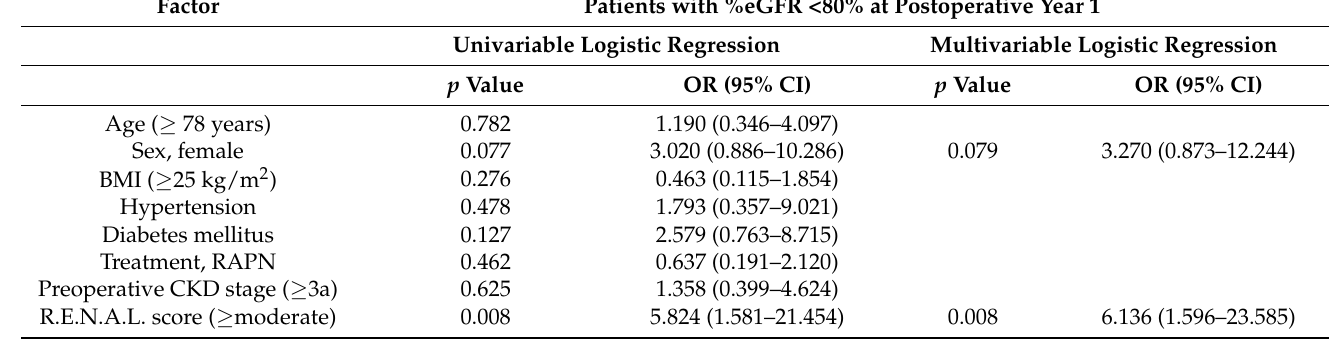
Table 4. Results of univariable and multivariable logistic regression analyses for factors associated with the risk of % eGFR <80% at postoperative year 1.